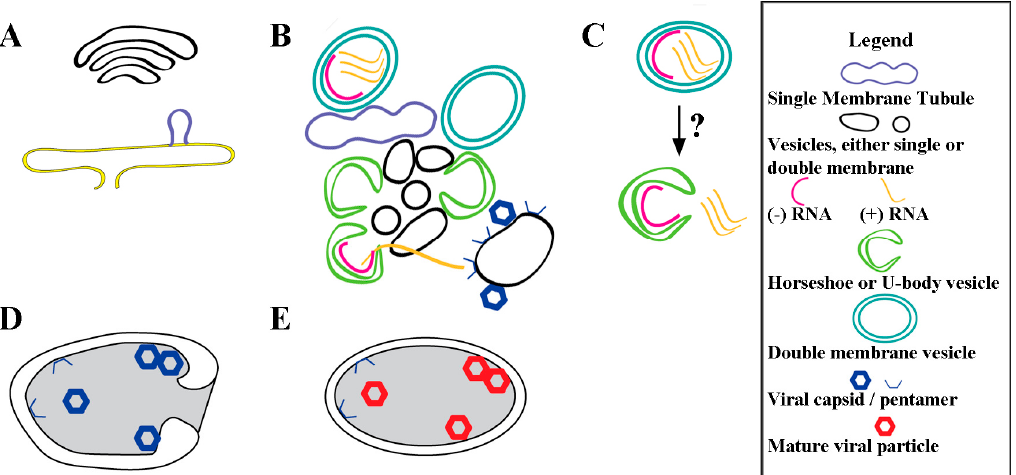
Figure 4. Virus ‐ induced membrane remodeling and expansion for poliovirus replication. ( A ) As early as 2.5 hpi, lipid buds off the ER [52], producing structures comprised of mostly virally induced lipids [11]; ( B ) New and pre ‐ existing cellular vesicles are dynamically remodeled [55] and invaginated from tubules into vesicles, and U ‐ bodies, using a unique lipid composition and specific virus proteins (listed in Tables 1 and 2). Only a fraction of the membranous structures are involved in active RNA replication within lumenal spaces. Throughout infection (+) RNA exits the replication factory, destined for translation or packaging. For virus assembly, (+) RNA interacts with membrane ‐ associated capsid protein pentamers on membranes that are distinct from replication factory membranes [70]; ( C ) Possible mechanism by which closed DMVs transitions to U ‐ body with gated lumen. These structures are visible at timepoints beginning 4 hpi and are believed to continue active replication; ( D ) Autophagosome ‐ like vesicle formation engulfs immature virus particles. These vesicles have twice the diameter of replication vesicles [71], and we posit that these membranes are distinct from those in RNA replication factories, which are still present in the